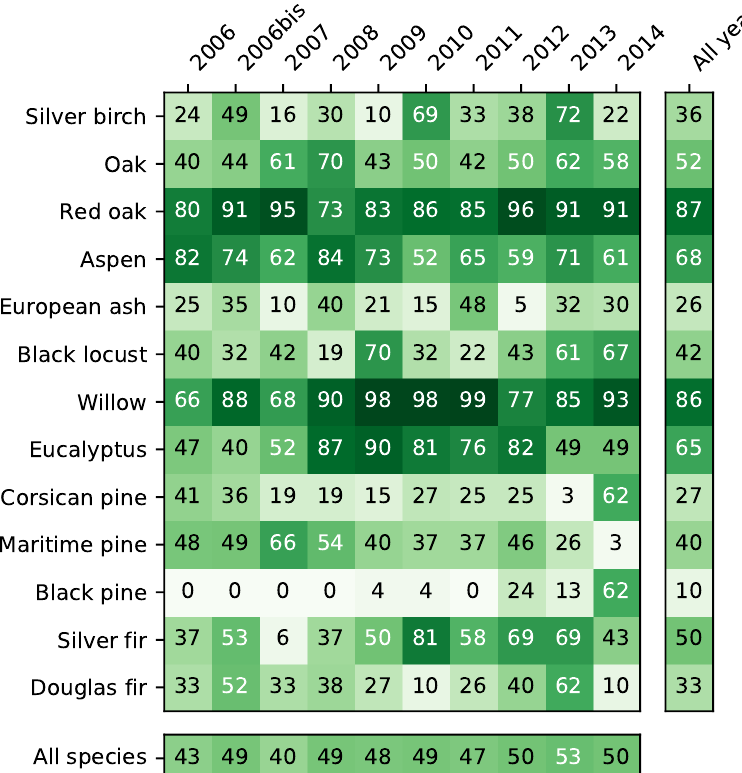
Figure 6. Average F1 score (in %) per species and per year based on the SLOO-CV sampling strategy using the Support Vector Machine (SVM) (RBF kernel) classifier. Values range from white (F1 score = 0%) to dark green (F1 score = 100%). Average values of F1 score per year and per species are also provided (in the bottom row and last column on the right,